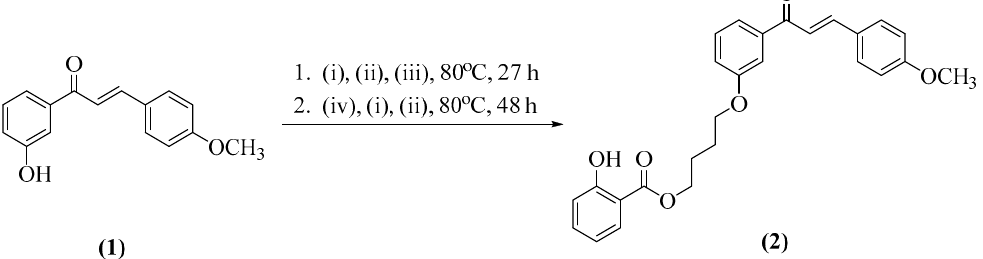
Figure 1. The synthesis route of title compound ( 2 ) under reflux condition, (i) ACN, (ii) K 2 CO 3 , (iii) (CH 2 ) 4 Br 2 , (iv) salicylic acid. The title compound in pure form was obtained as clear yellow crystal in